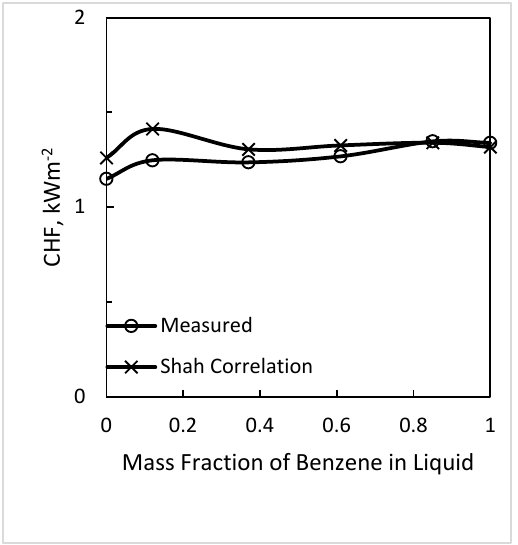
Figure 2. Comparison of the data from Andrews et al. (1968) [12] for the benzene–toluene mixture in an annulus with the Shah (2015a) [27] correlation. Liquid velocity is 2.18 ms − 1 , inlet subcooling is 40 K, and pressure is atmospheric.